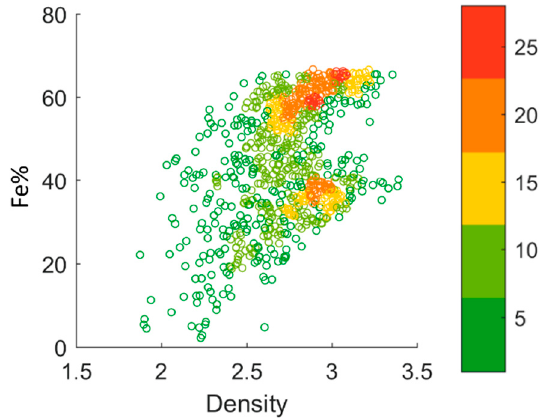
Figure 11. Heat scatter (data density) cross-plot of Fe% and density. There are two apparent groups of iron concentration, which both have similar densities. A prediction of iron grade based on density is therefore not possible.